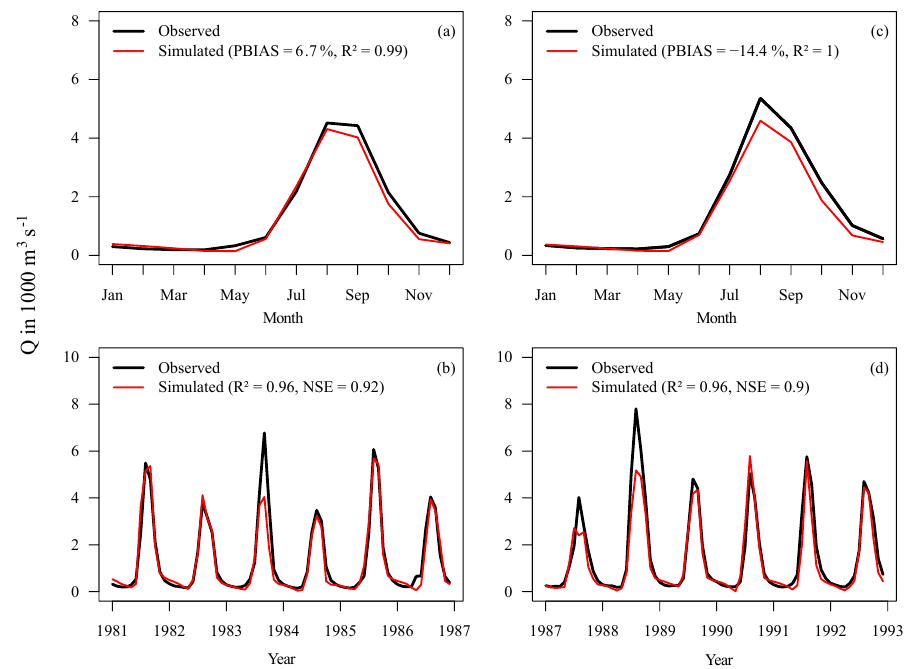
Figure 2. Simulated discharges for calibration (a, b) and validation (c, d) periods at gauge El Diem (Sudan border) using WATCH Forcing Data (WFD). The annual cycle is shown in the top row and average monthly discharges in the bottom